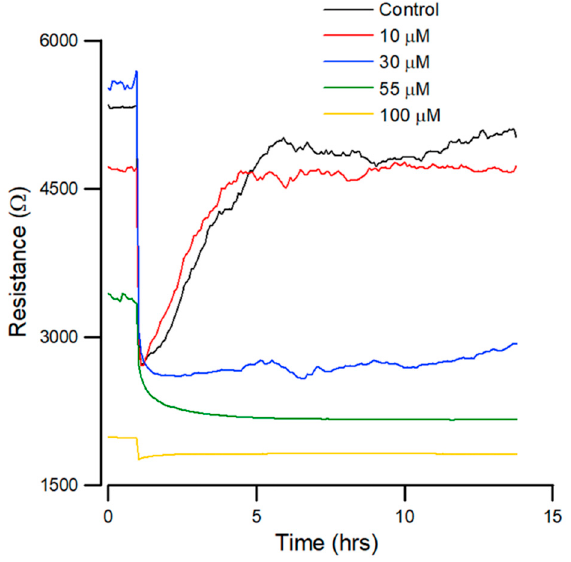
Figure 4. Effect of andrographolide on the wound healing migration of OEC-M1 cells, as measured by ECIS. Wound healing assay of andrographolide at concentrations of control (black), 10 (red), 30 (blue), 55 (green), and 100 μ M (yellow) ( n = 5).